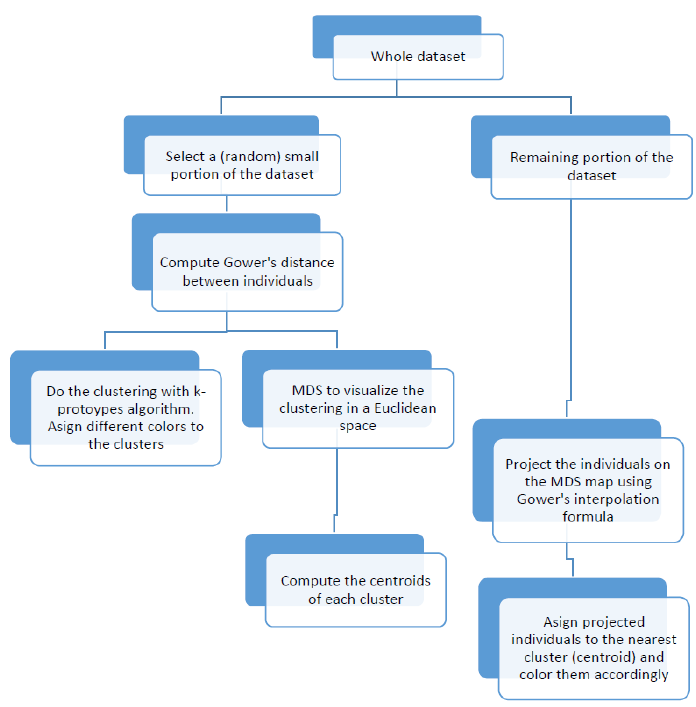
Figure 1. Flowchart of the visualization